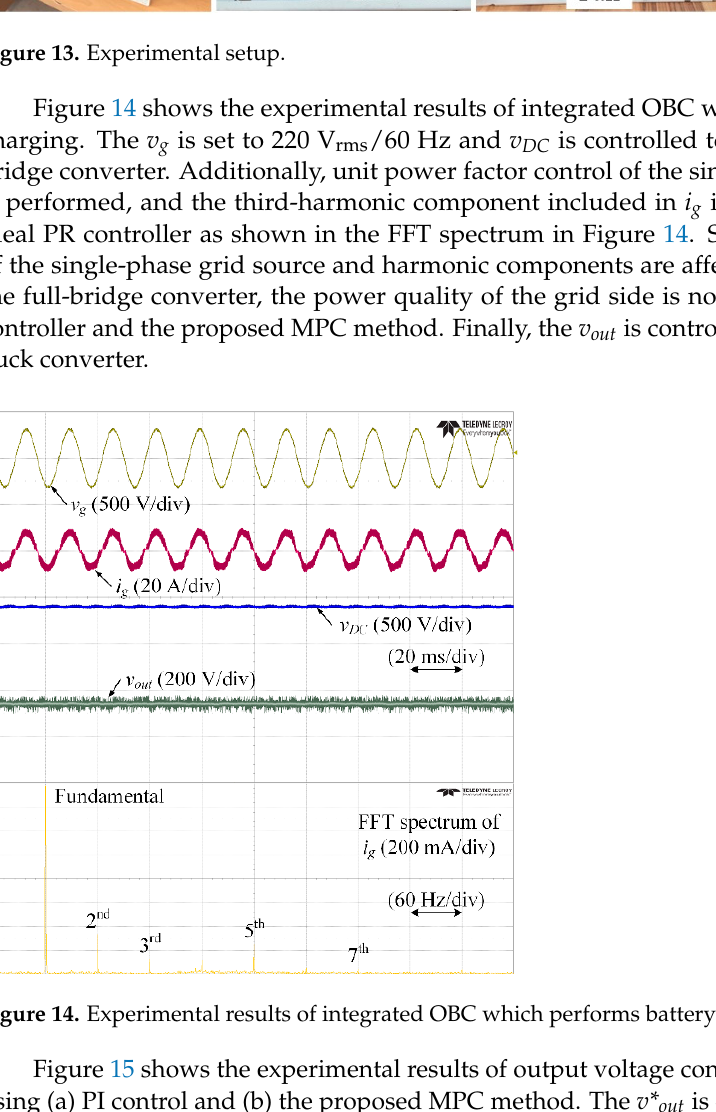
Figure 13. Experimental setup.